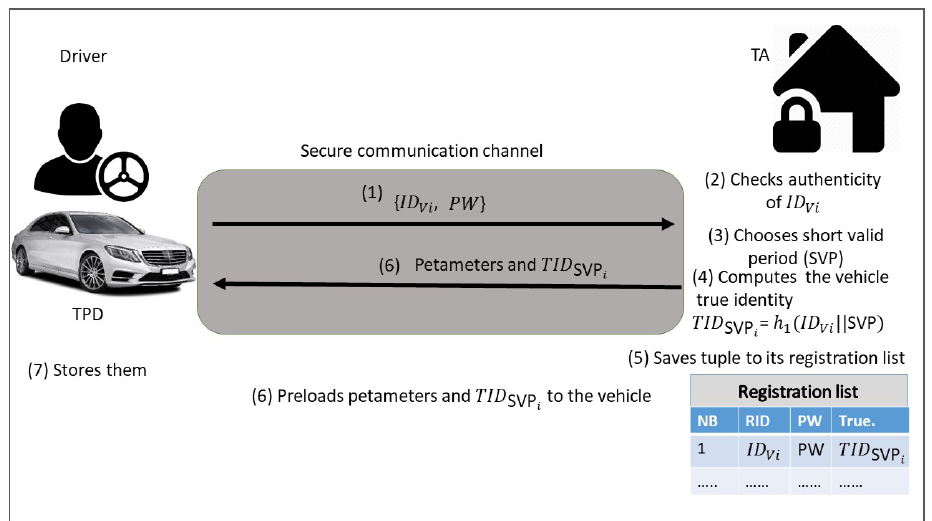
Figure 2. Process of vehicle registration